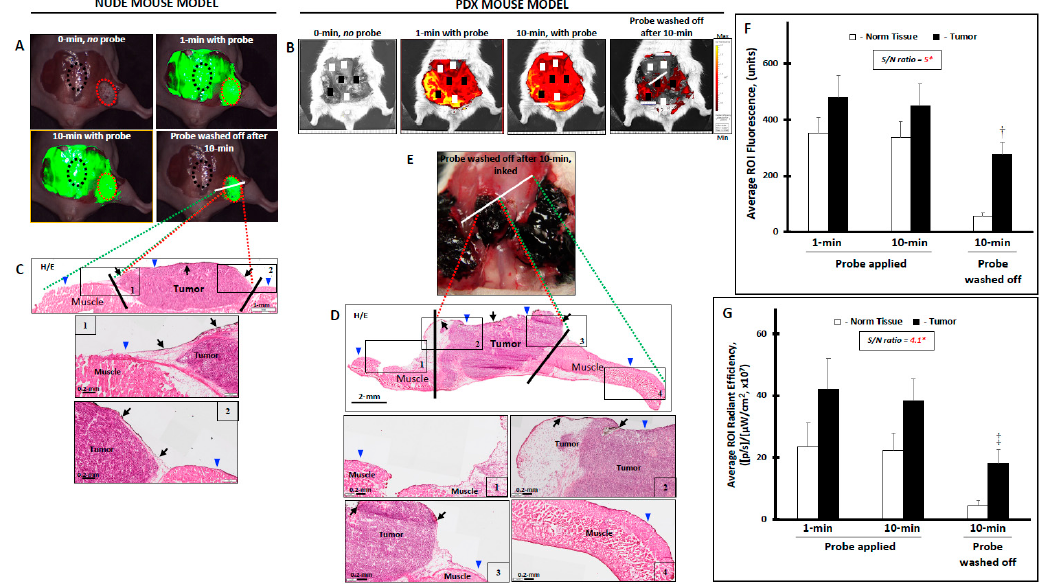
Figure 4. Topical application of AKRO-QC-ICG imaging Pluronic F-127 hydro-gel#30 visualizes and helps to demarcate the human BCa tissue from normal mouse tissue in vivo. ( A )—The levels of ICG fluorescence in the surgical cavity of athymic nude mouse with MDA-MB-468 human breast cancer cell xenograft. Tip of the tumor xenograft (up to 40% of visible tumor) was cut off, bleeding was cauterized, and AKRO-QC-ICG imaging hydro-gel#30 (AKRO-QC-ICG = 50 μ M final) was topically applied onto all surfaces of the abdominal muscle wall along with tumor xenografts. After 10 min of incubation, the imaging gel was washed away with sterile saline from everywhere, including tumor, and surgical cavity was imaged. Based on this 10 min image, only high fluorescent zones were inked by a black pathological ink. White line—plane of section. ( B )—The levels of ICG fluorescence in the surgical cavity of NSG PDX mouse with xenografts that were grown from the human breast cancer cells isolated from patient TM00098. Tips of the tumor xenografts (up to 40% of visible tumor) were cut off, bleeding was cauterized, and AKRO-QC-ICG imaging hydro-gel#30 (AKRO-QC-ICG = 50 μ M final) was topically applied onto all surfaces of the abdominal muscle wall along with tumor xenografts. After 10 min of incubation, the imaging gel was washed away with sterile saline from everywhere, including tumor, and surgical cavity was imaged. Based on this 10 min image, only high fluorescent zones were inked by a black pathological ink. White line—plane of section. ( C )—Bread-loaf section and H&E histology of ( A ); blue triangles indicate the surface where the imaging gel was applied. Inserts-1 and -2 show borders between normal tissue and cancer (bottom—with high magnification). Black arrows—ink in the tumor zone. Black lines demarcate the cancer zone border. ( D )—Pathology ink on the tumor surfaces of the surgical cavity that was used to mark the areas of high ICG-fluorescence in ( B ). ( E )—Bread-loaf section and H&E histology of ( B ), blue triangles indicate the surface where the probe was applied. Inserts-1 and -4 (upper panel) show normal tissue and inserts-2 and -3 show borders between normal tissue and cancer (bottom panel—with high magnification). Black arrows—ink in the tumor zone. Black lines demarcate the cancer zone border. ( F )—The average levels of fluorescence in the ROIs of the tumor (red dotted circles) and normal (black dotted circles) tissue as represented in the surgical cavity in ( A ) for all athymic nude mice, n = 12. ( G )—The average levels of fluorescence in the ROIs of the tumor (black squares) and normal (white squares) tissue as represented in the surgical cavity in ( B ) for all NSG PDX mice, n = 10. Notes: (1) *—normalized to 0 min pre-image = background; (2) †— p < 0.001 to normal tissue at 10 min (n = 12), when the imaging gel was washed off in ( F ); ‡— p < 0.005 to normal tissue at 10 min (n = 10), when the imaging gel was washed off in ( G ) by Student’s t -test; 3) Vertical bars—SD; 4) cameras: Curadel Lab-Flare RP1 and Curadel Resvet software in athymic nude mice and IVIS ® Spectrum in vivo imaging system and software in NSG PDX